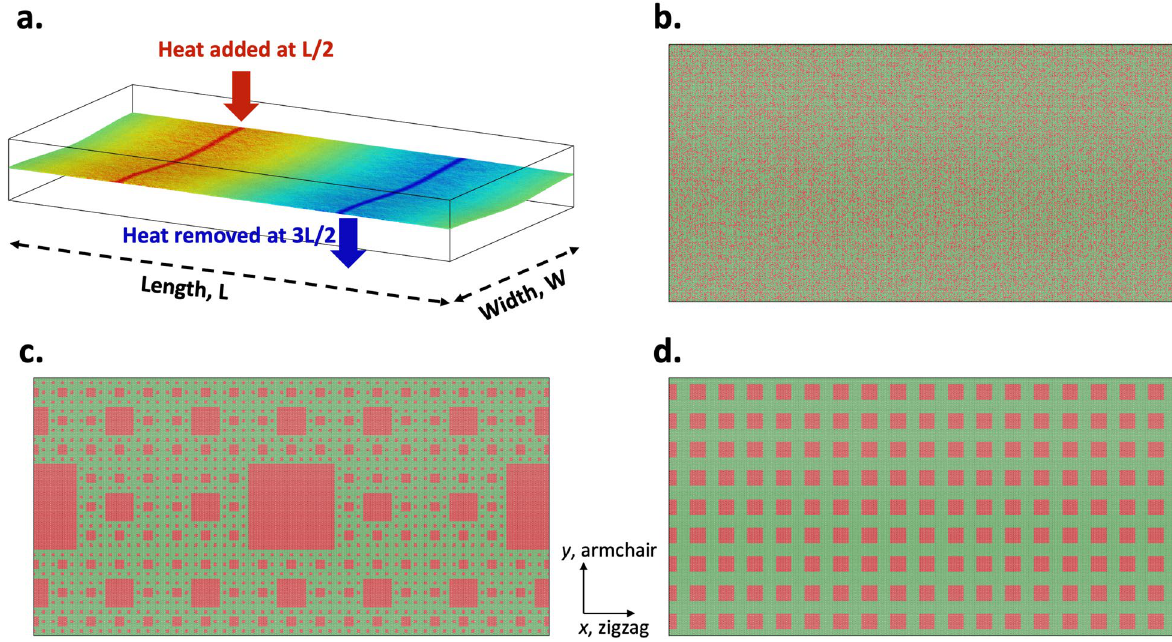
Figure 1. ( a ) Schematic of the thermal conductivity simulation. Heat is added at L/2 and removed at 3L/2 establishing a thermal gradient between the hot and cold regions. ( b – d ) Different ( Mo | W ) Se 2 systems with different phonon scattering features. ( b ) Shows a random distribution of WSe 2 (red) in a MoSe 2 (green) system, corresponding to a 40% distribution of WSe 2 in MoSe 2 . ( c ) Shows a level 4 fractal heterostructure and ( d ) shows a periodic MoSe 2 | WSe 2